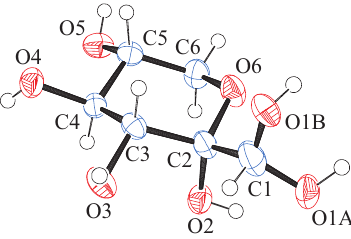
Figure 1. Structure of the D -sorbose molecule and atomic labeling in the room temperature phase. Since O1A and O1B atoms and bonding hydrogens result from the structural disorder, they are exclusive to each other. Hydrogen atoms bonding to oxygen atoms share the same number with respect to oxygen